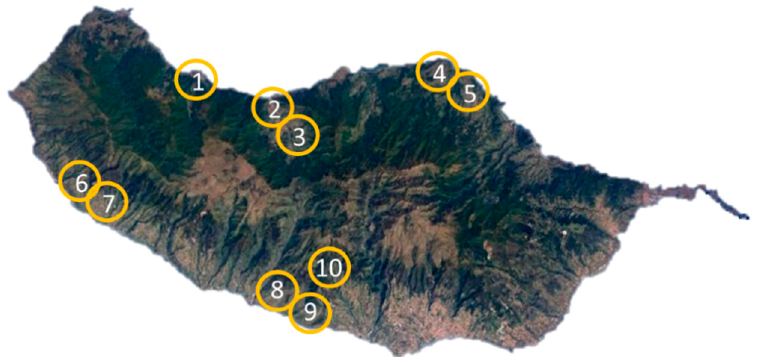
Figure 1. Sampling zones (varieties): 1—Seixal (Sercial); 2—São Vicente (Tinta Negra); 3—São Vicente (Verdelho); 4—São Jorge (Malvasia de São Jorge); 5—São Jorge (Bastardo); 6—Prazeres (Verdelho); 7—Calheta (Terrantez); 8—Campanário (Boal); 9—Fajã dos Padres (Malvasia Cândida); 10—Jardim da Serra (Sercial) (Madeira Island map adapted from Google Maps. Imagens ©2020 TerraMetrics).